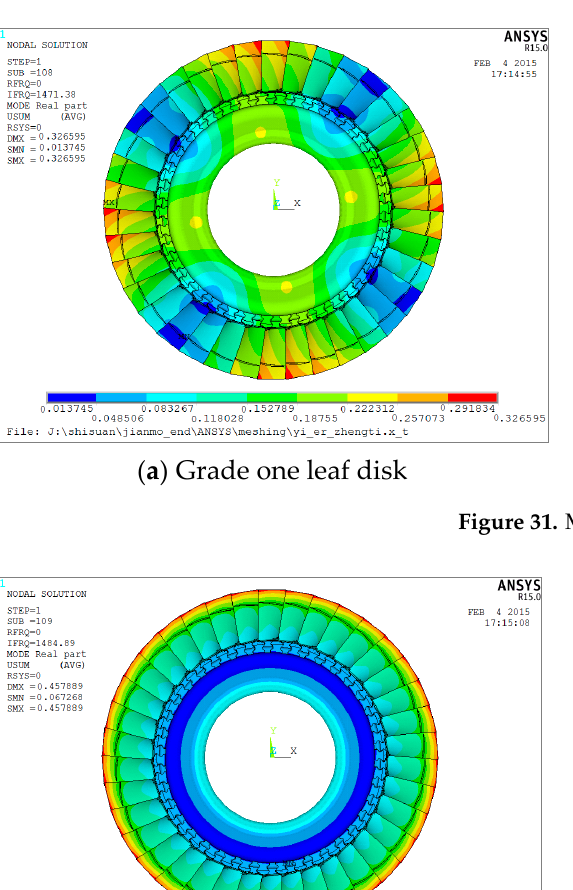
Figure 30. Mode 99. 5 10 − ×